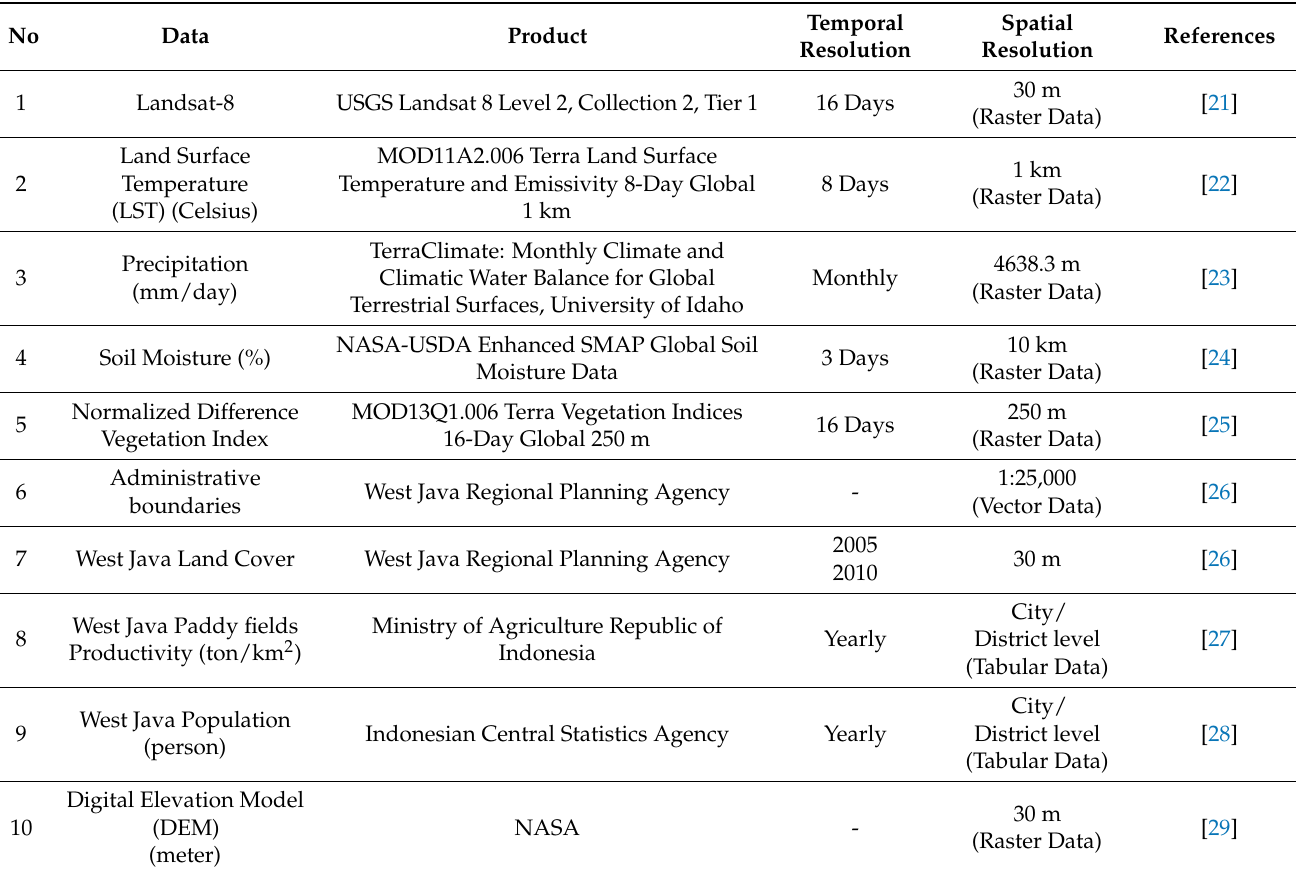
Table 1. Data used in the